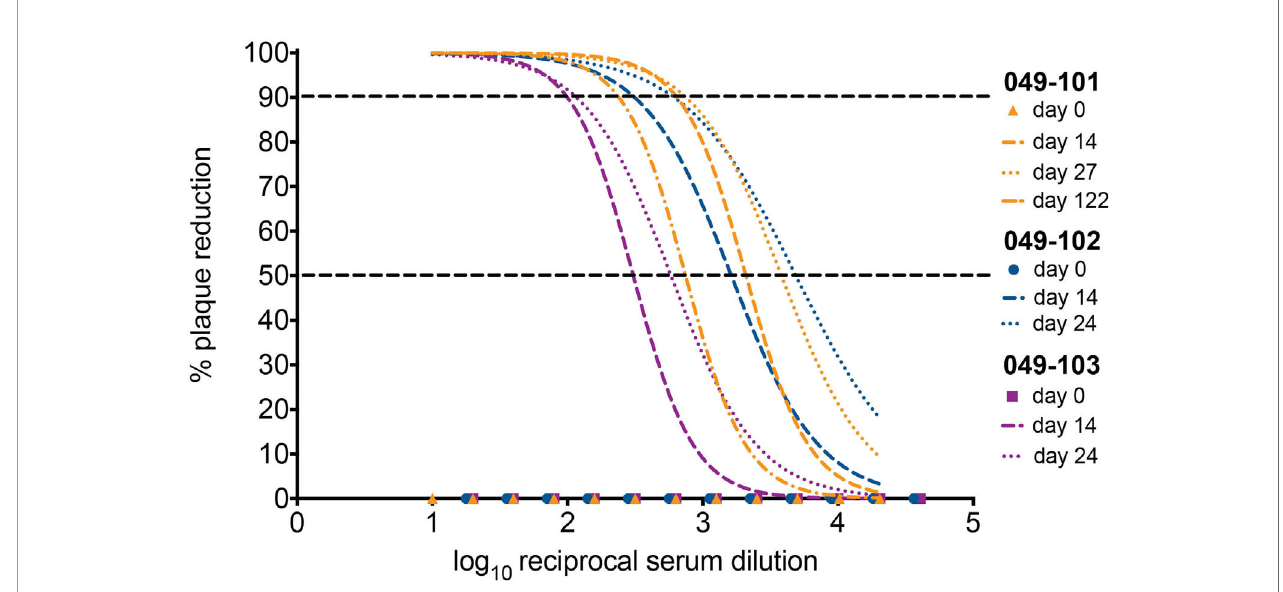
FIGURE 5 | All three dams developed neutralizing antibodies (nAbs) against ZIKV as detected by PRNT 90 following intravaginal ZIKV infection. The x-axis is the log10 reciprocal serum dilution and the y-axis is the percent plaque reduction for ZIKV-DAK. Day 0 for all animals is shown as symbols with 049-101 represented by orange triangles, 049-102 represented by blue circles, and 049-103 represented by magenta squares. Dashed gray horizontal lines indicate the PRNT 90 and PRNT 50 cut-offs, respectively. Neutralization curves were generated using non-linear regression to estimate the dilution of serum required to inhibit 90% of Vero cell culture infection. Neutralization curves are shown for days 14 (dashed lines) and 24 (dotted lines) for dams 049-102 (blue) and 049-103 (magenta), and for days 14, 27, and 122 (dashed and dotted line) for dam 049-101